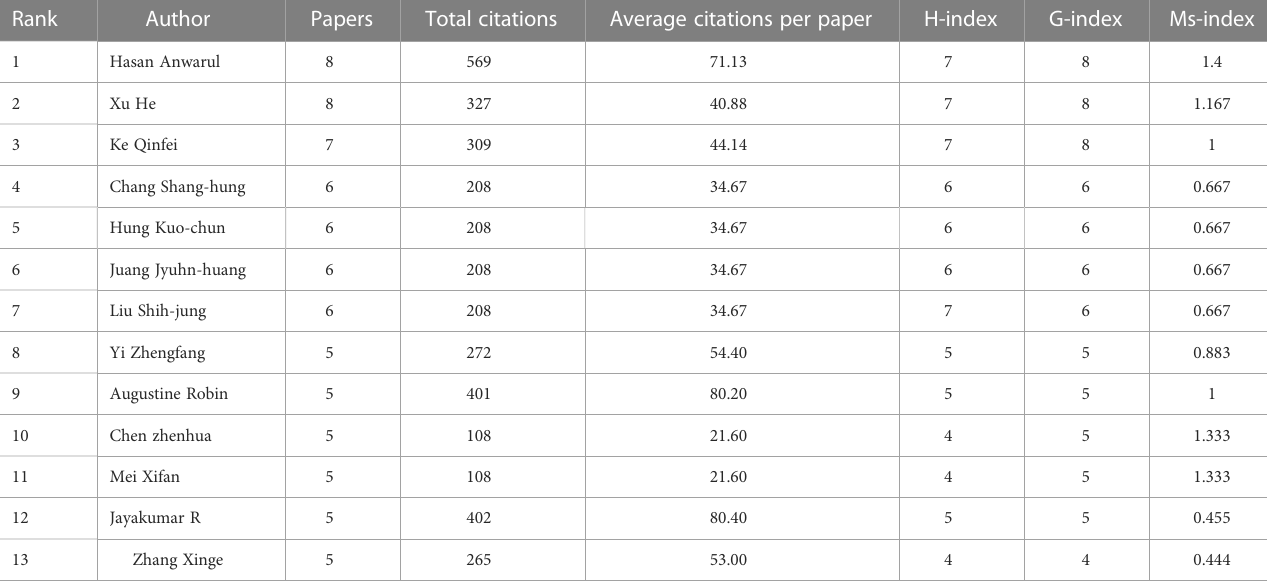
TABLE 3 The top 13 authors in the fi eld of nanomaterials and diabetic wound healing.